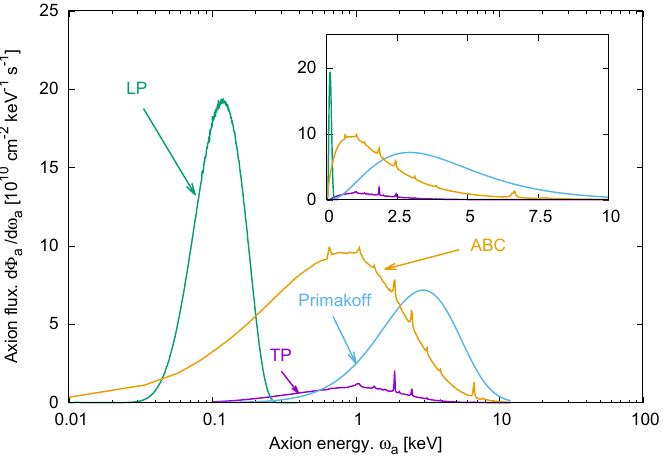
Figure 3. The different solar axion components produced in the interior of the sun. The recently calculated longitudinal plasmon (LP) and transversal plasmon (TP) [75,76], together with the more conventional and well-known axion flux components; Primakoff and electron coupling ABC flux components[38,77]. The TP component is chosen to be that of a solar model with a monochromatic spectral opacity. The flux data shown in this plot have been generated using the code provided at reference[78]. A linear energy scale is shown in the embedded